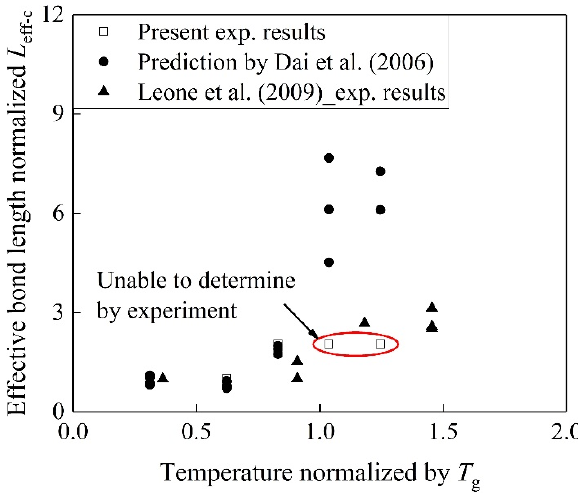
Figure 9. E ff ective bond length normalized by L e ff -c vs. temperature at surface of BFRP normalized by T g